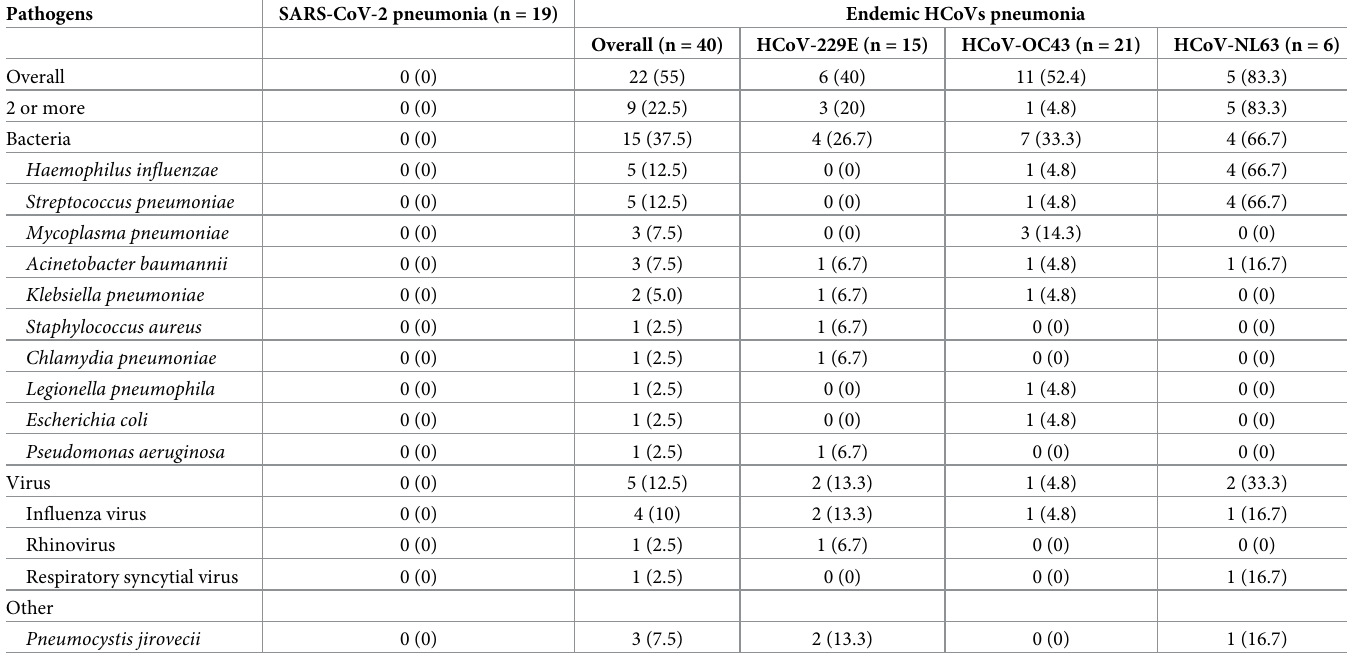
Data are shown as a number